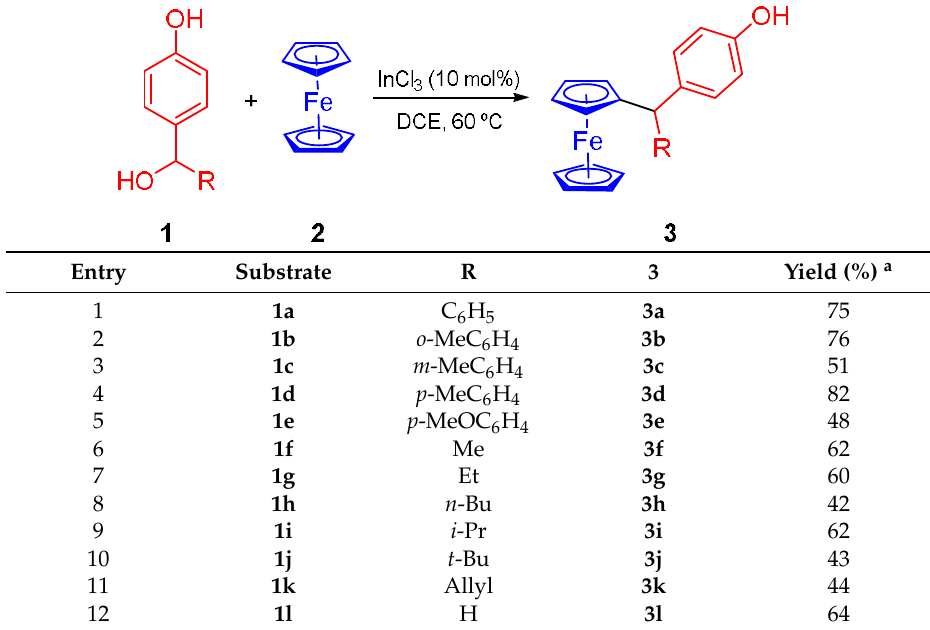
4 1d p -MeC 6 H 4